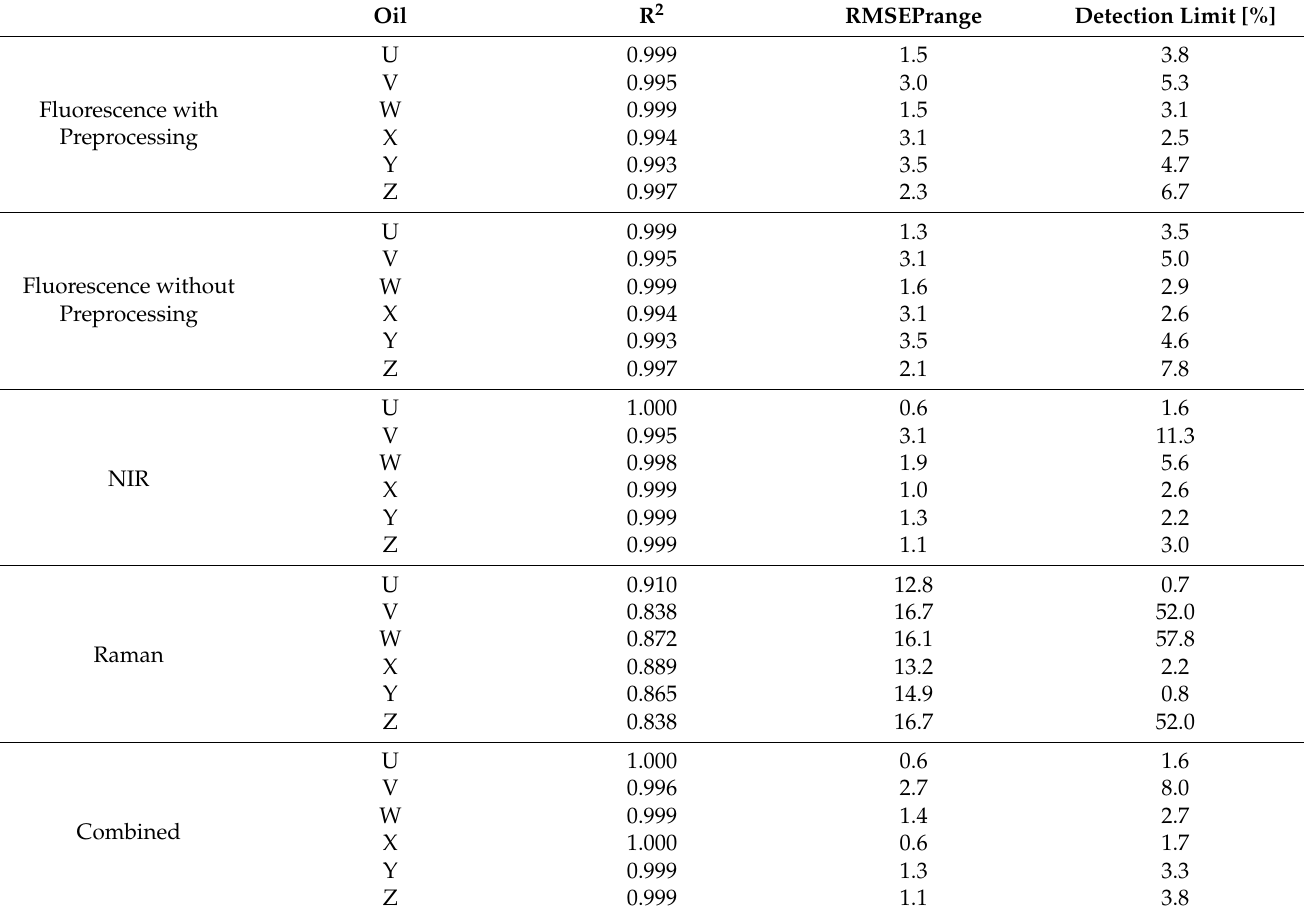
Table 7. Results of the best PLSR predictions for the single chia oils U, V, W, X, Y and Z with single evaluations of the adulteration oil S separately for all methods and the combination of all